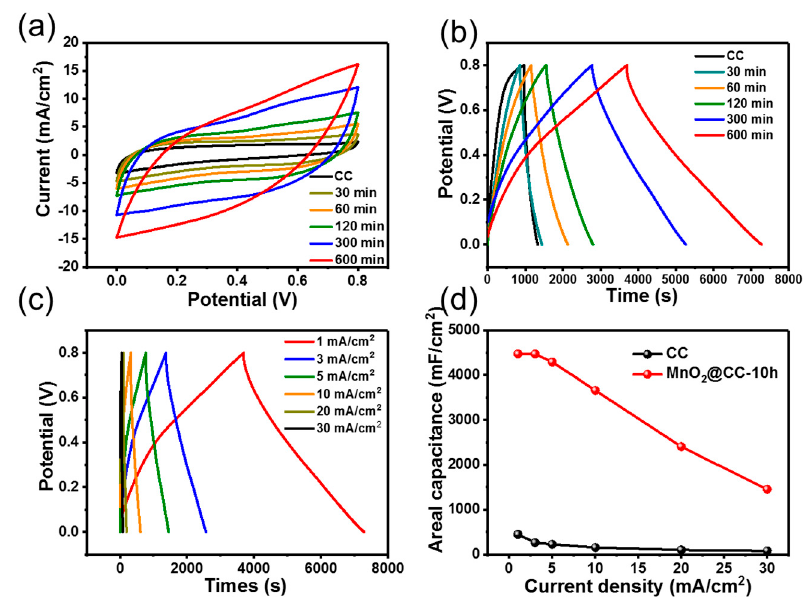
Figure 5. Electrochemical performance of the MnO 2 @CC electrode: ( a ) CV curves of MnO 2 @CC with different deposition times at scan rate of 5 mV s − 1 . ( b ) Charge–discharge profiles of MnO 2 @CC with different deposition times at a current density of 1 mA/cm 2 . ( c ) Charge–discharge profiles of MnO 2 @CC-10 h at different current densities. ( d ) The area-specific capacitance of MnO 2 @CC.